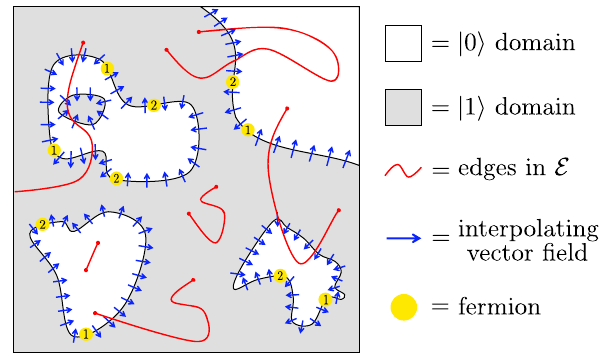
Q ˆ s 1 − ˆ s ˆ p Þ q pq on a domain wall S ð h pqr i